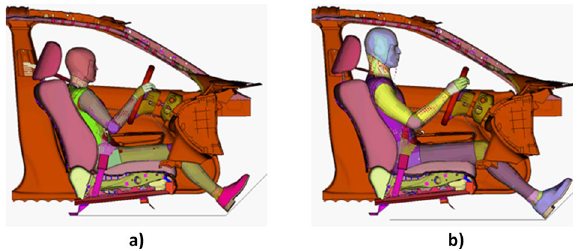
Figure 1. GHBMC human models in driving position ( a ) 5th female, ( b ) 50th